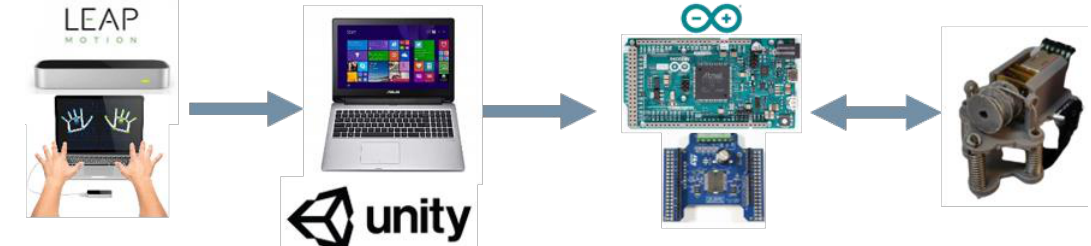
Figure 1. Scheduled illustration of the upper limb rehabilitation platform: LeapMotion ( on the left ), Arduino board ( center-right ), and the prototype of the thimble ( on the right ).